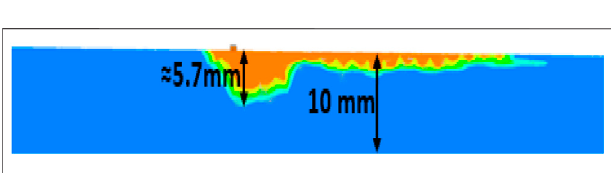
FIGURE 10 | Clot formed in simulation after 30 s, based on a computational setup mimicking experimental